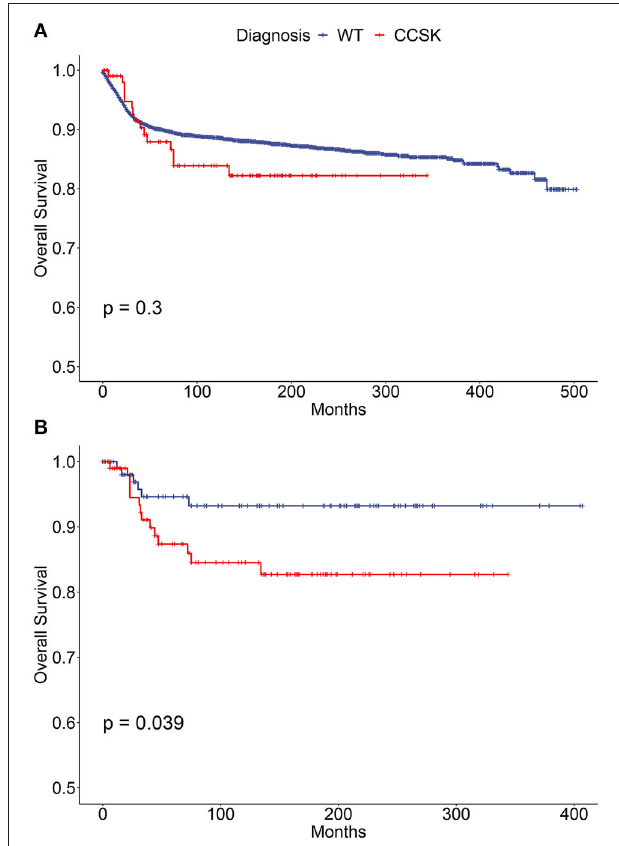
FIGURE 2 | Survival curves of children (0–19 years) with WT and CCSK. (A) Before propensity score matching; (B) After propensity score matching. WT, Wilms tumor; CCSK, clear cell sarcoma of